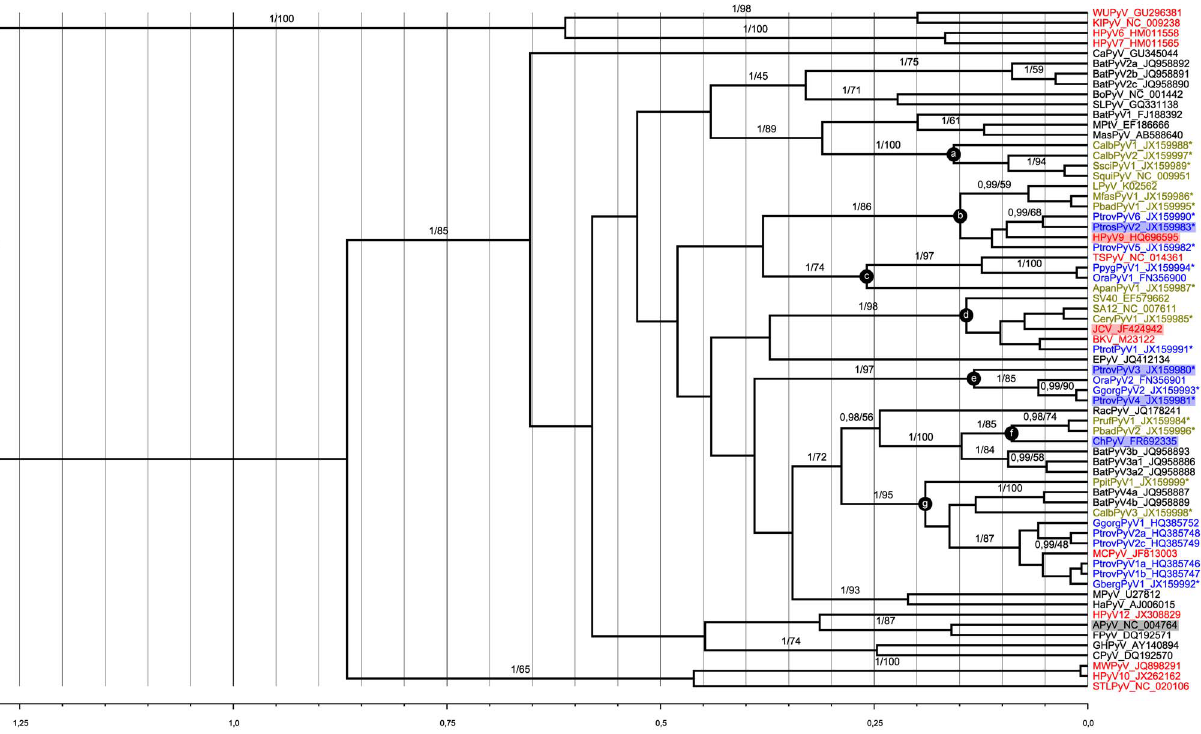
Figure 1. Bayesian chronogram deduced from the analysis of a 244 amino acid alignment of VP1 sequences. Polyomaviruses were identified in humans (red), apes (blue), other primates (green), and other mammals and birds (black). Novel polyomaviruses identified in this study are marked with a star and relevant clades to which they belong are highlighted by lettered circles. Viruses from which VP1 was used in serological assays are highlighted by colored rectangles. The human polyomavirus MXPyV has the same phylogenetic position as HPyV10 and is not shown. Support values are given above branches where posterior probability (pp) . 0.95 and bootstrap values (Bp) . 50. The tree presented is the maximum clade credibility tree. The scale axis is indicated in amino acid substitutions per site.